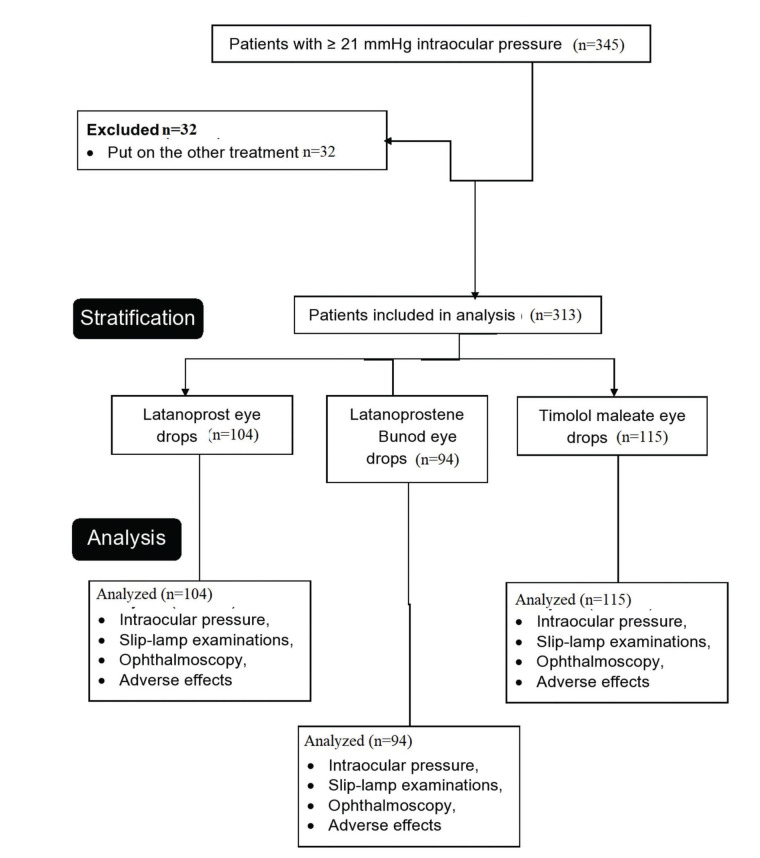
Flow chart of the study.